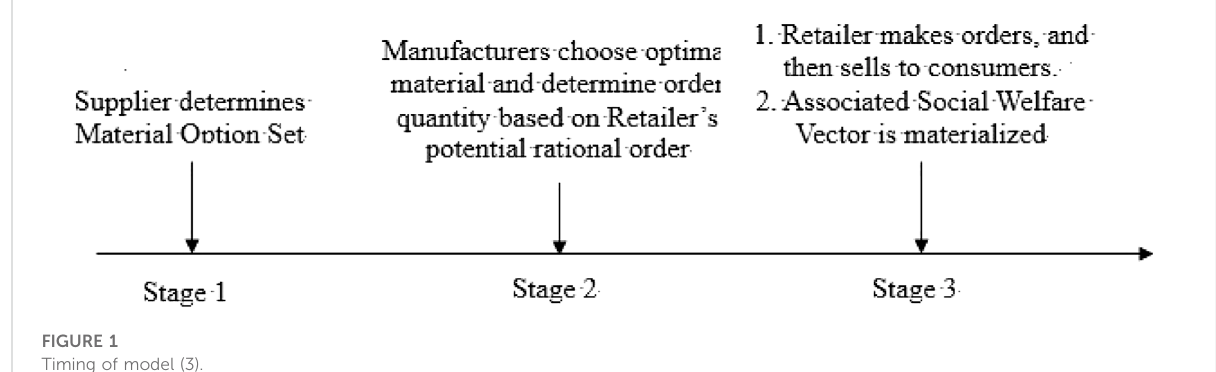
FIGURE 1 Timing of model